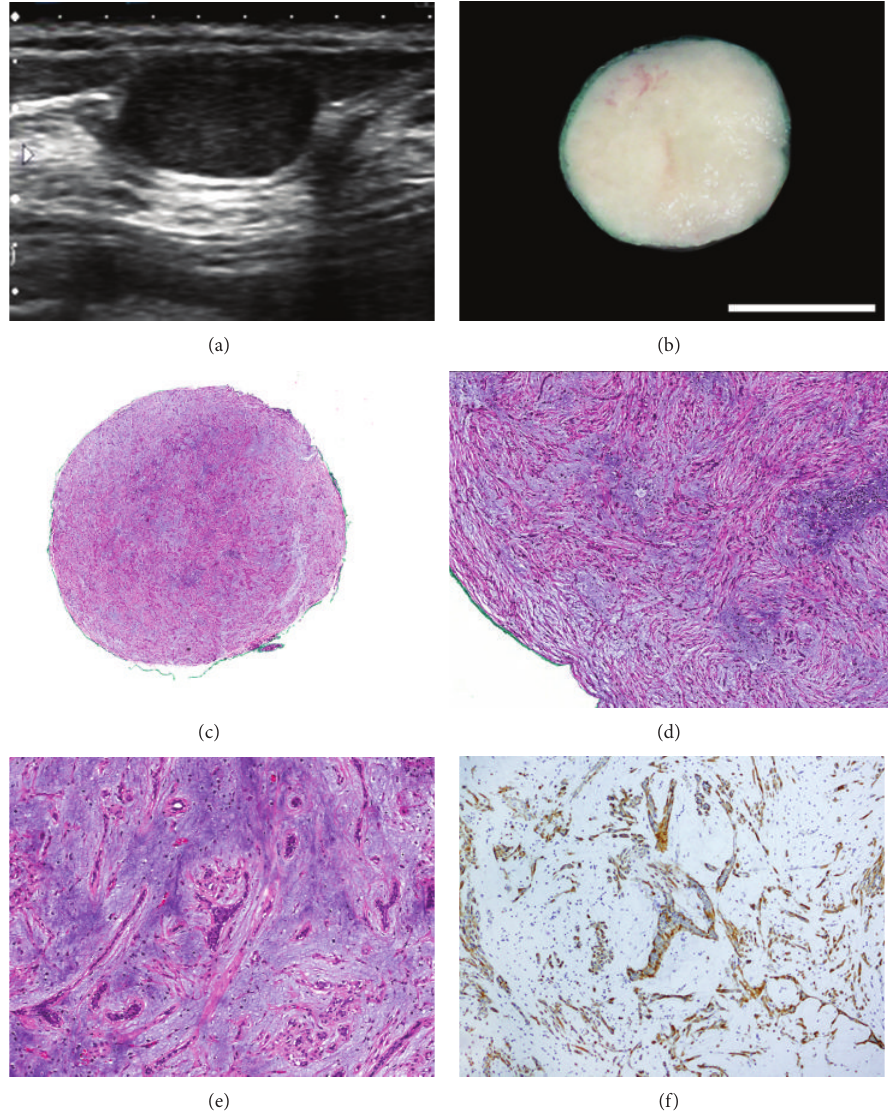
Figure 1: Pleomorphic adenoma of the breast. (a) Ultrasound showing a well-circumscribed, hypoechoic mass. (b) Cut sectioning showed a firm, well-circumscribed mass with whitish, homogeneous surface (bar: 1.0cm). ((c) and (d)) Histological section shows the tumor to be composed of stromal and epithelial elements. The stromal component is comprised of bland spindle cells embedded in a myxochondroid matrix. (e) The epithelial component shows scattered compressed glands interspersed in the stroma. (f) Calponin immunostain highlights stromal and periglandular myoepithelial cells. The epithelial cells are negative for